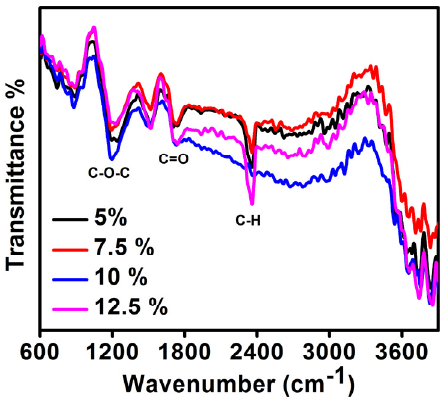
Figure 4. FTIR spectra of synthesized electrodes with varying PVDF concentrations.